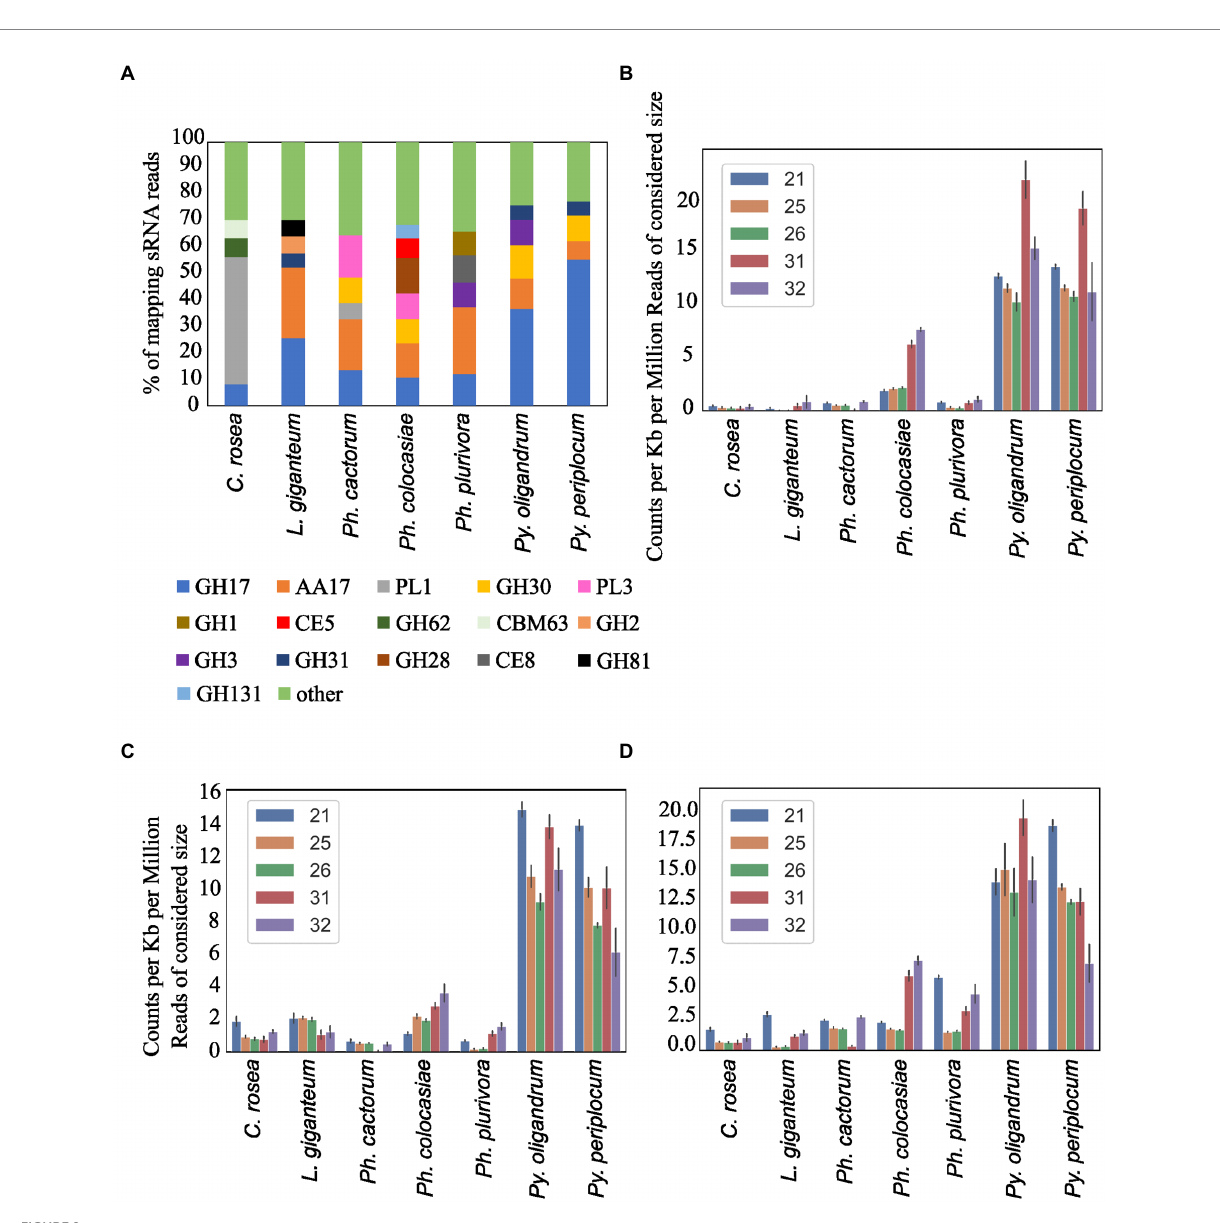
FIGURE 9 Distribution of the sRNA reads mapping to secreted CAZyme families in the species of interest (A) . Number of reads mapping to secreted CAZymes (B) , proteases (C) and secreted proteins not predicted to be CAZymes, proteases, CRNs or RxLRs (D) . Data normalized according to total kb extent of the respective gene area in the genome and to millions of reads of the specific sRNA size for the sample. Error bars indicate the standard